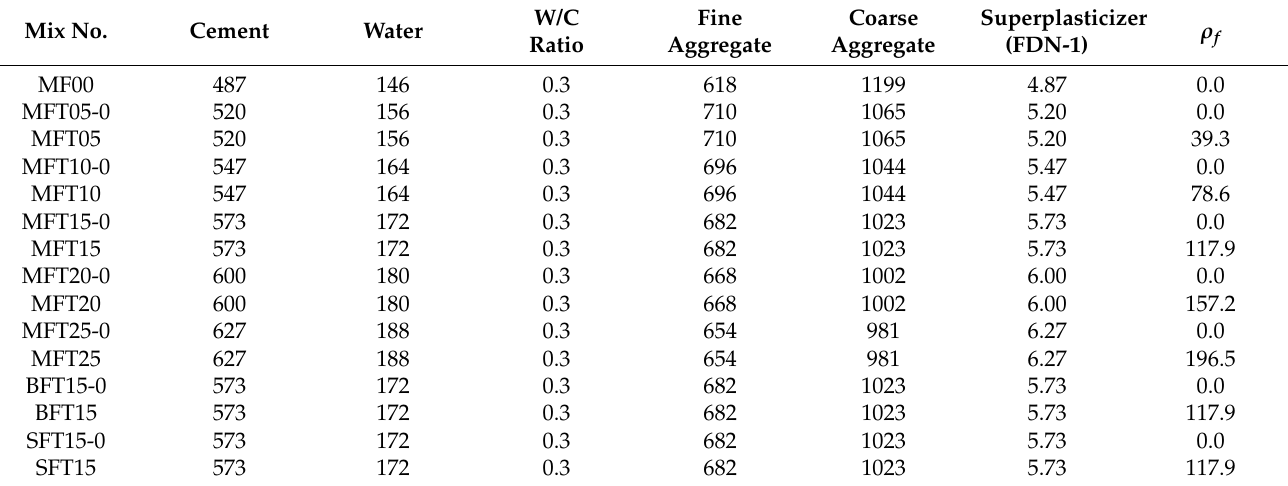
Table 2. Mix proportions of SFHSC and HSC (unit, kg/m 3 ).